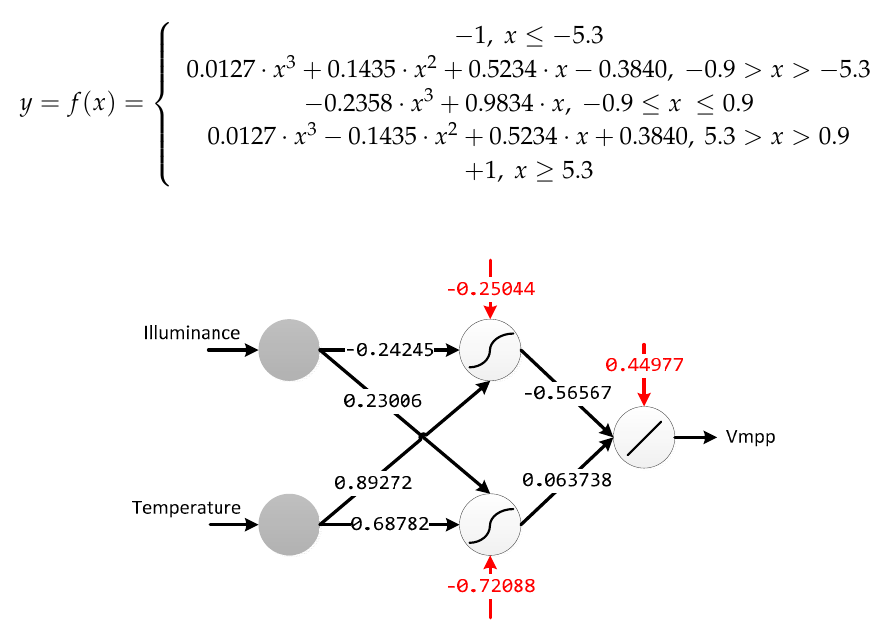
Figure 11. Multilayer perceptron weight values obtained to modelling the solar panel behavior. Red values correspond to bias weights.